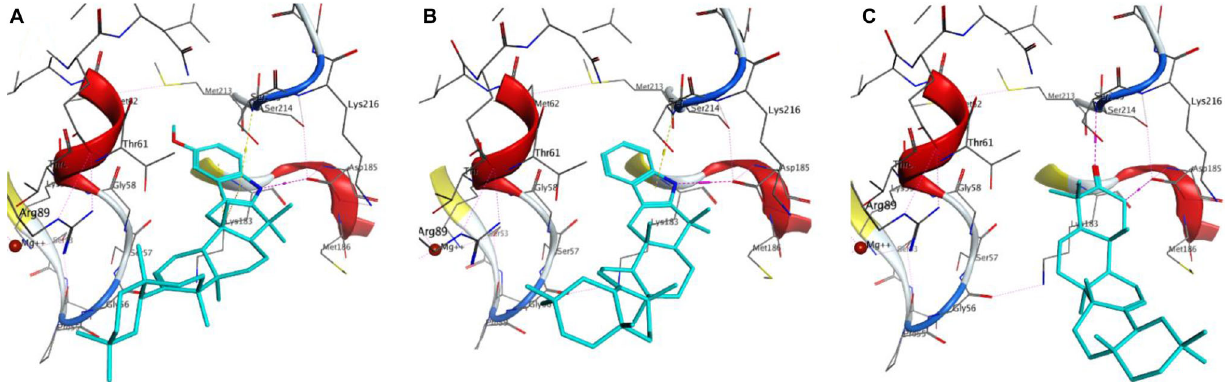
Fig. 4 Displaying of the docked pose of the complete molecules a 3 , b 4 , c